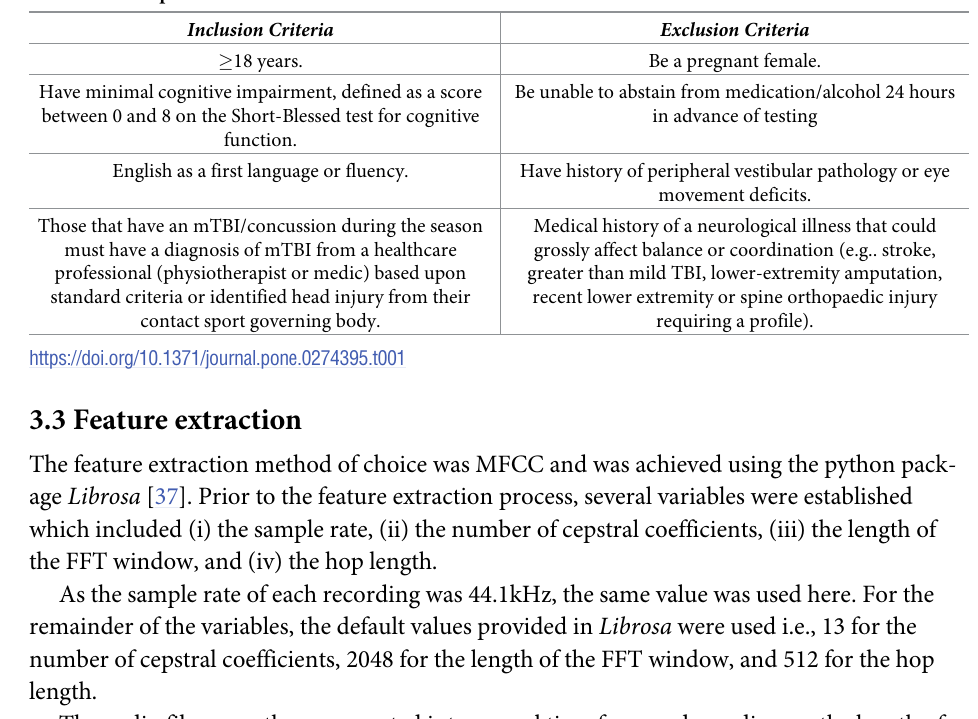
Table 1. Participant inclusion and exclusion